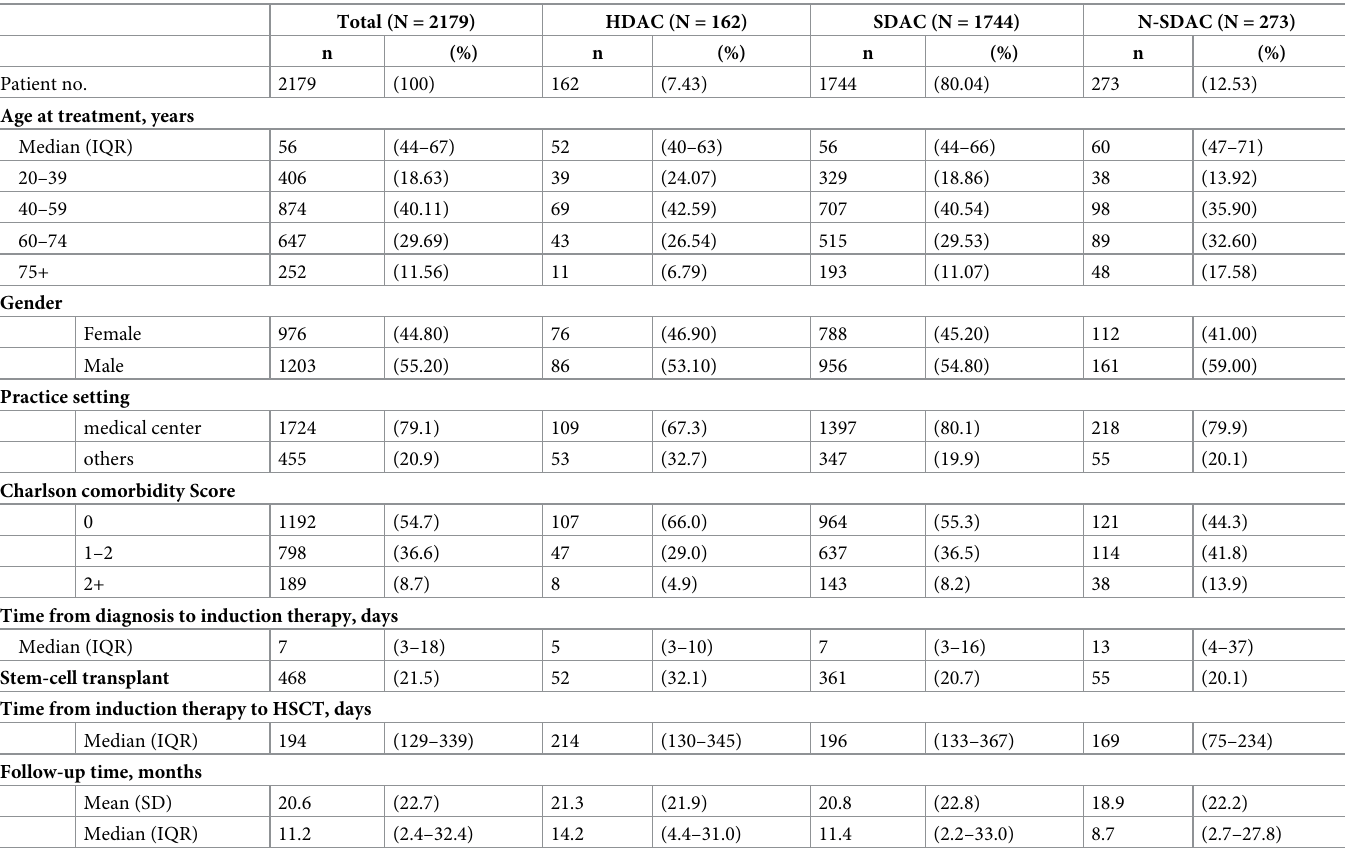
Table 1. Baseline and disease characteristics of AML patients who received induction therapy between 2011 and